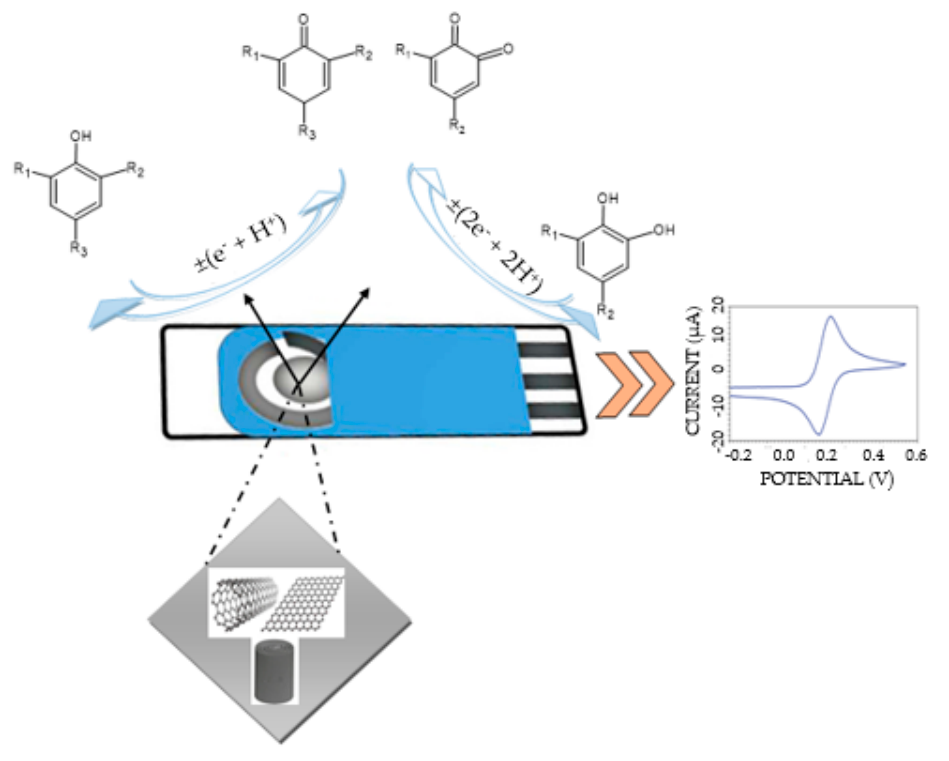
Figure 3. Schematic representation for the mechanism of mono- and di-phenolic compound detection using the electrochemical method.